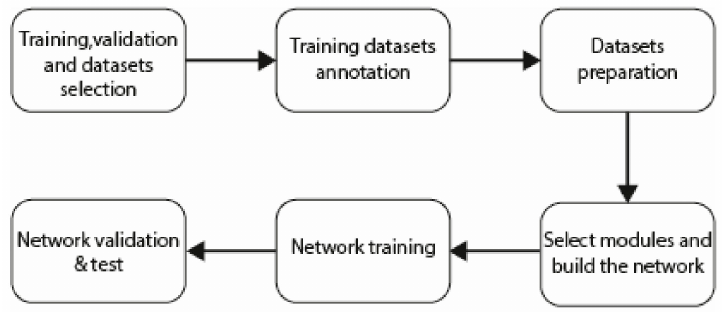
Figure 1. The steps of the proposed